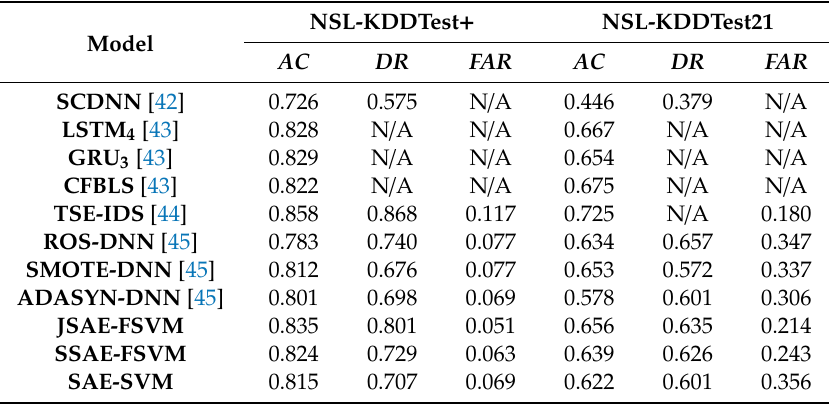
Table 7. Comparison with the state-of-the-art